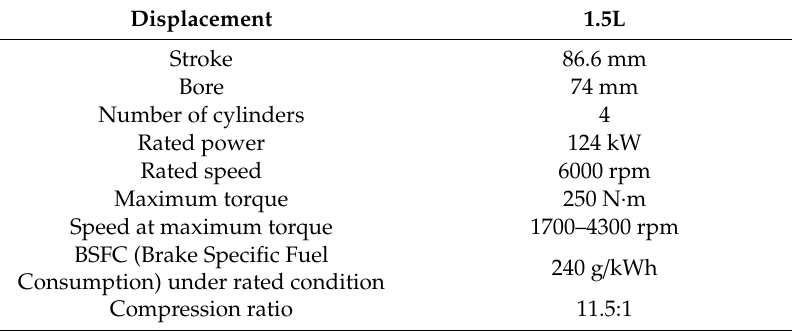
Table 1. Specifications of the research